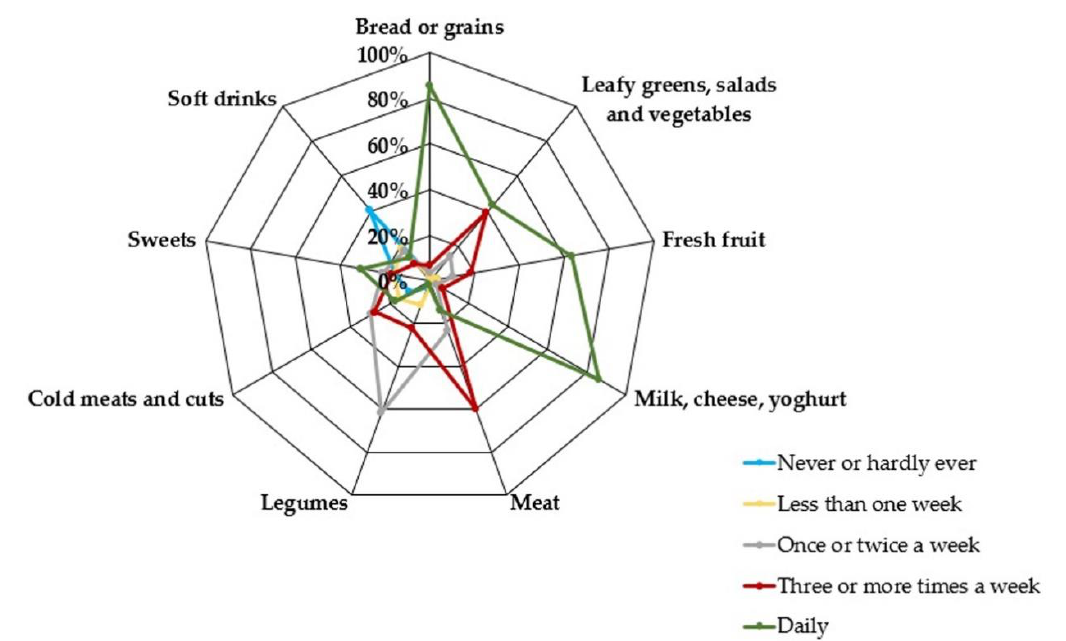
Figure 1. Frequency of food consumption in workers aged 16–64 years ( n = 27,455) (2006–2017). From 2006 to 2017, the percentage of workers who consumed leafy greens, salads, and vegetables, at most, once or twice per week decreased (2006: 23.70%, 2011: 17.28%, 2017: 11.43% (B = −0.78, R 2 = 0.95, p < 0.001)). On the other hand, there was an increase in the consumption of milk, cheese, or yoghurt ≥3 times per week but not in daily consump- tion (2006: 4.18%, 2011: 7.08%, 2017: 9.79% (B = 10.15, R 2 = 0.99, p = 0.04)). In addition, there was an increase in workers who consumed soft drinks ≥3 times per week but not in daily consumption (2006: 9.59%, 2011: 9.94%, 2017: 10.48% (B = 1.53, R 2 = 0.98, p = 0.04)) (Table